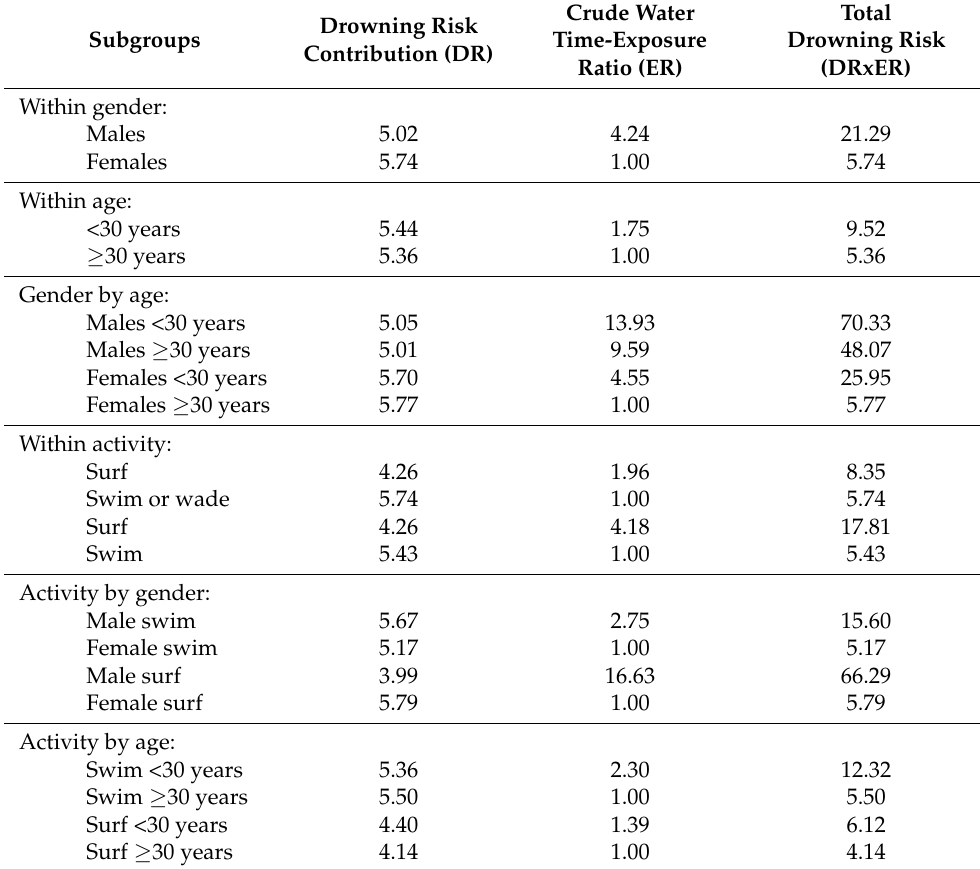
Table 3. Subgroup drowning risk based on risk factors and exposure to